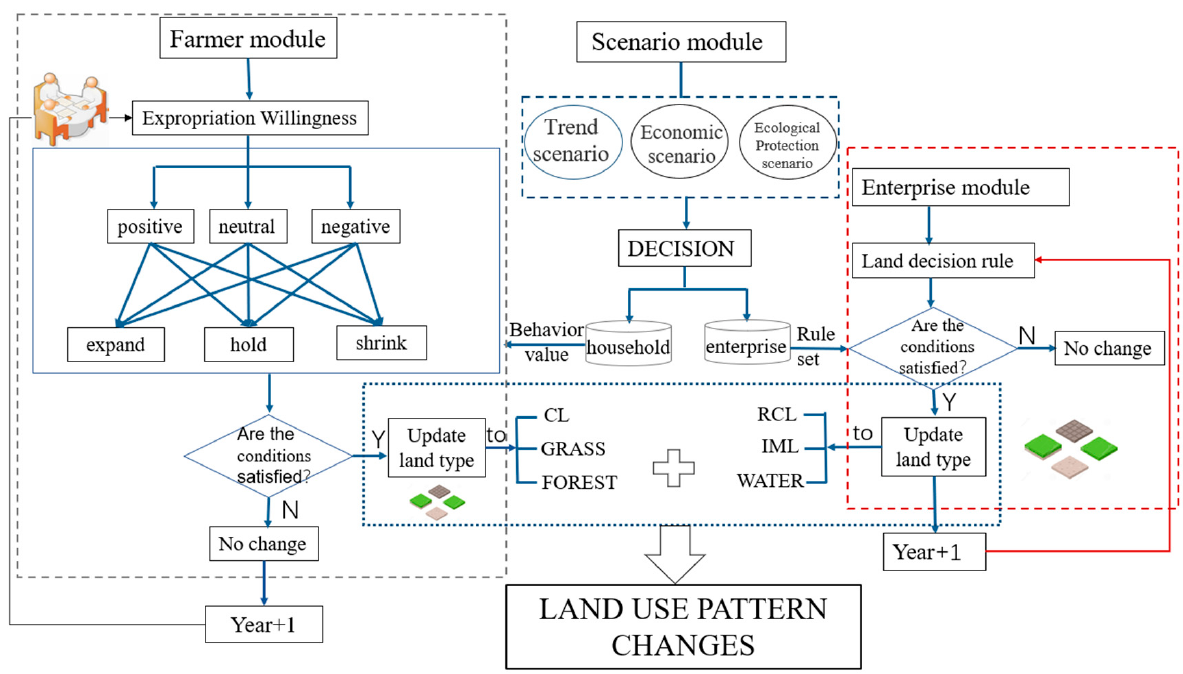
Figure 3. The framework of the MAS-LUCC model in the study. (1)